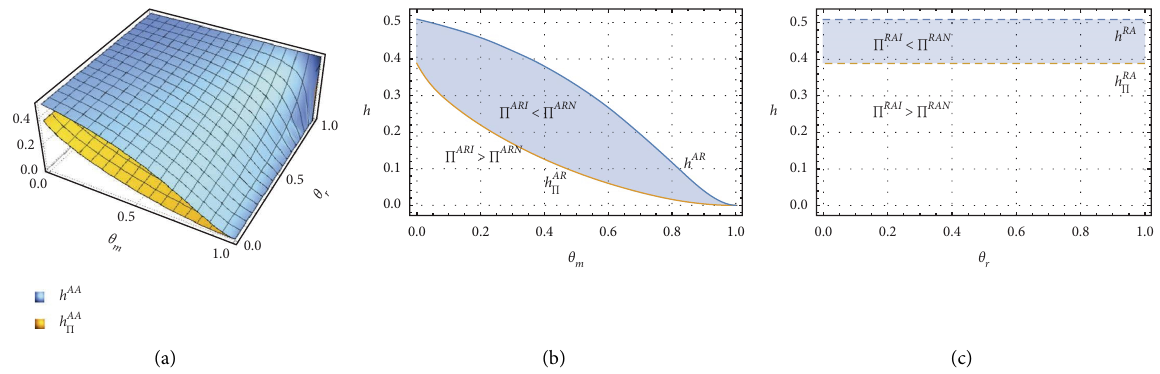
Figure 6: Tresholds of the supply chain’s profts for diferent altruistic scenarios ( a � 1 , b � 0 . 5 ,c � 0 . 2 , c � 1 ) . (a) Both members are altruistic. (b) Only the manufacturer is altruistic. (c) Only the retailer is altruistic.